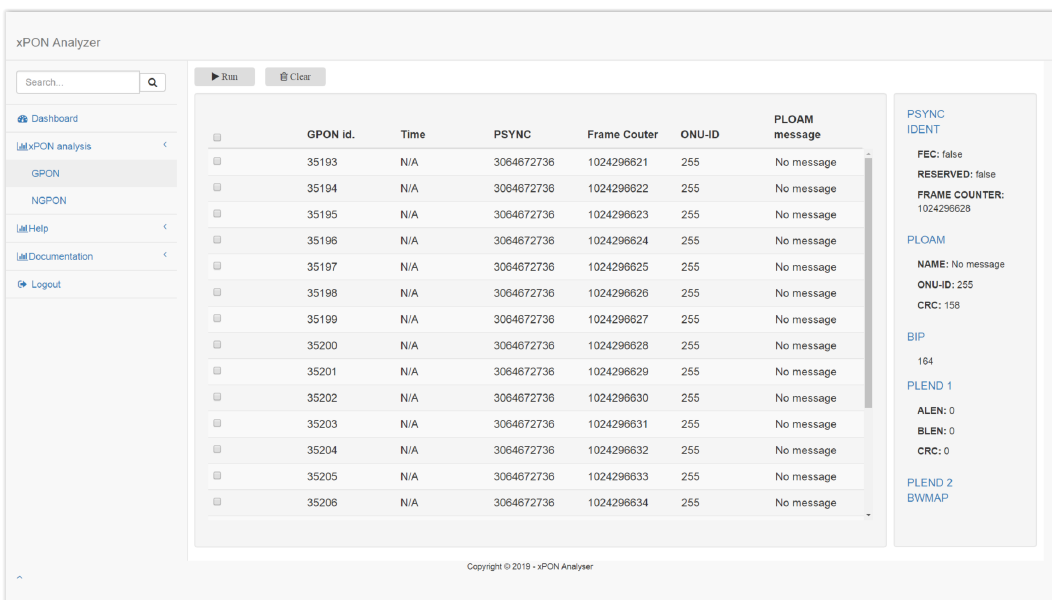
Figure 8. Web tool for